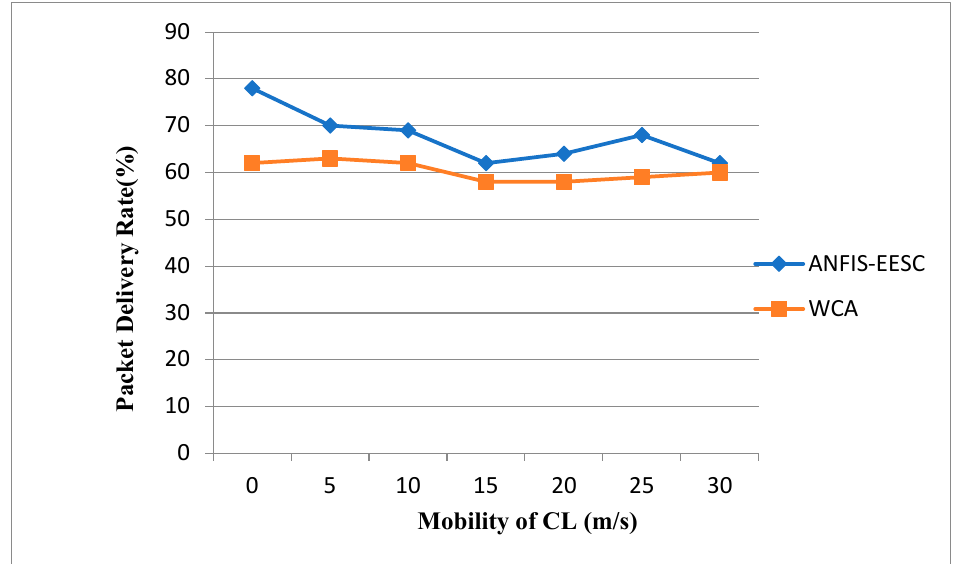
Figure 5. Packet delivery rate with respect to Mobility of CL.